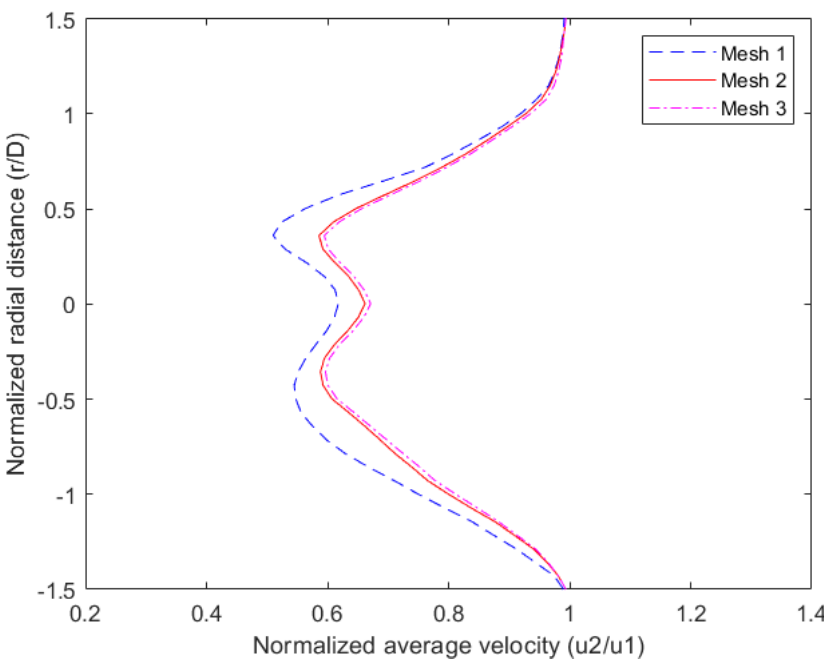
Figure 7. Mesh sensitivity study results of a pentagon platform.